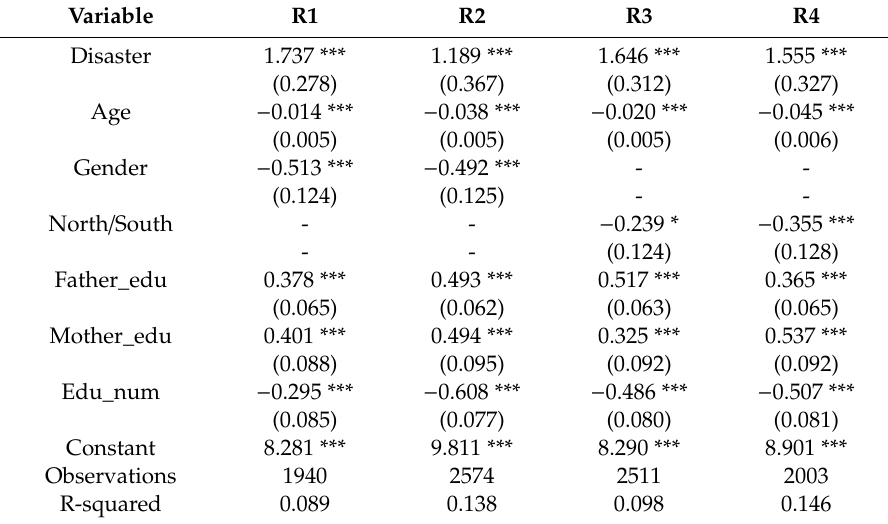
Table 8. Impact of disaster frequency of subsamples human capital divided by north / south and male / female, OLS